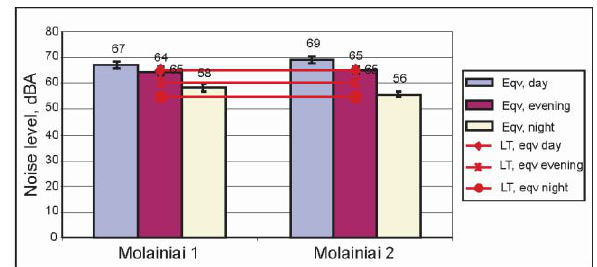
Fig. 10. Dynamics of equivalent noise levels in Molainiai street within twenty four hours